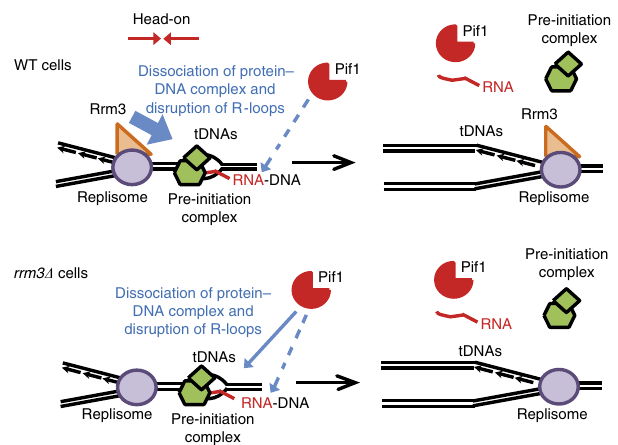
Figure 5 | Model for Pif1 and Rrm3 function at tDNAs. During replication, Rrm3 plays the main role (thick blue arrow) in promoting replication fork progression and maintaining genome integrity at tDNAs by displacing both the RNA Pol III pre-initiation complex, which impedes fork progression, and R-loops, which cause DNA damage. Pif1 provides a backup for Rrm3 in both R-loop removal (dashed blue arrow) and protein displacement (thin blue arrow) at replicating